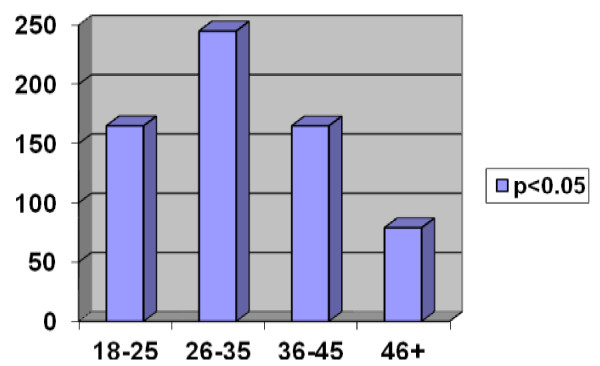
Distribution of cases by age range.